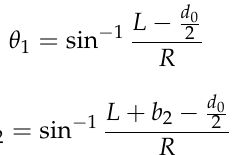
Figure 6. Diagram of O-ring sealing groove structure.